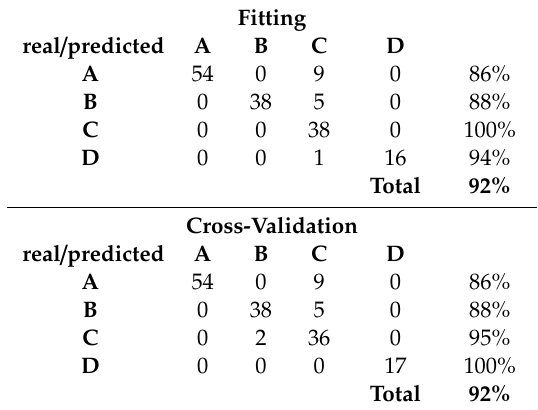
Table 4. Confusion matrix of the PLS-DA classification model (fitting and validation results are both reported). Cross validation ‘venetian blinds’ technique was used with the number of cv groups equal to 3. True classes are read along the columns and estimated classes along the rows. The total accuracy was also reported.